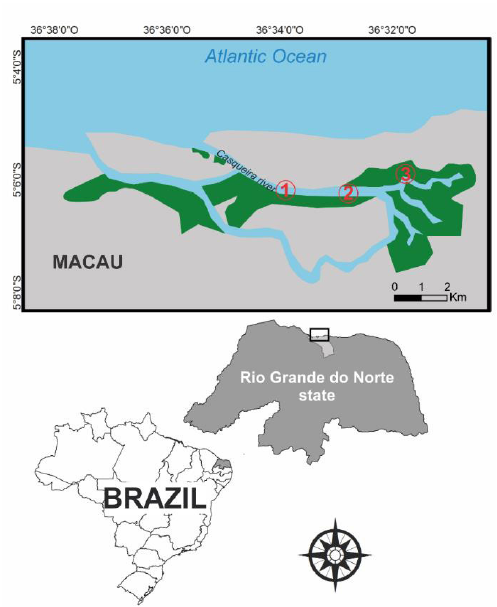
Figure 1. Geographical representation of the study area and sampling stations 1, 2 and